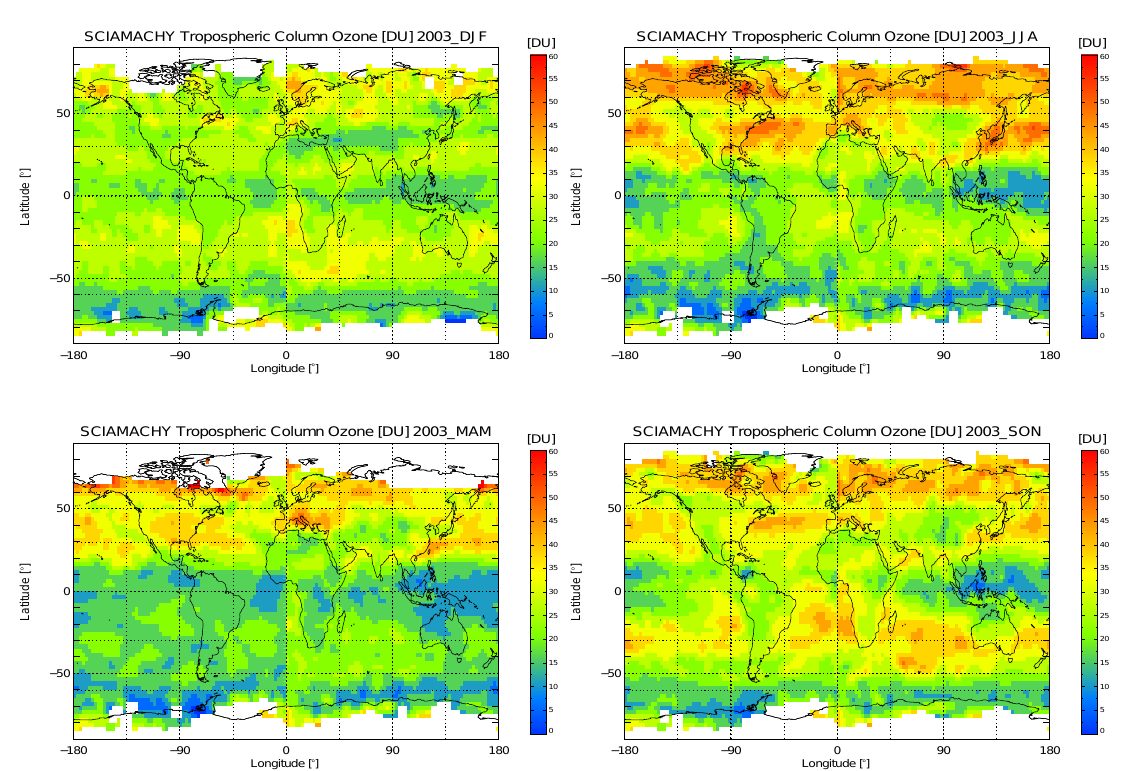
Figure 14. Tropospheric ozone distributions in Dobson units retrieved from SCIAMACHY observations for different seasons in 2003; top panels from left to right: December-January-February, and June-July-August, bottom panels from left to right: March-April-May and September-October-November.